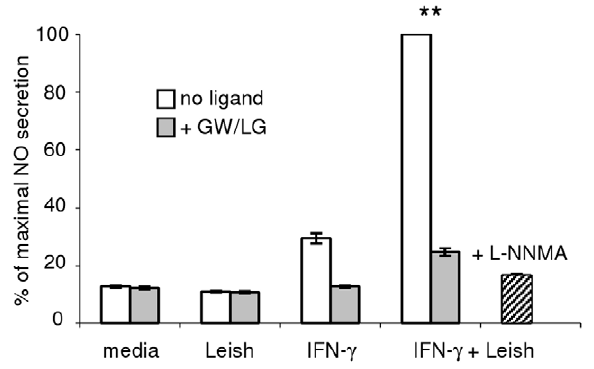
Figure 4. NO production by macrophages stimulated with IFN- c + Leishmania is inhibited by LXR ligands. BMDM were preincubated overnight with LXR (GW = GW3965) and RXR (LG = LG268) ligands, with or without IFN- c , prior to a 1 hour in vitro infection with stationary-phase L. chagasi/infantum . Amount of NO secreted in 24 hours by wild-type BMDM stimulated with IFN- c + Leishmania in the absence of ligand was normalized to 100%. L-NNMA is a NOS inhibitor. Error bars represent standard deviations of triplicate NO measurements. Results are representative of at least 3 independent experiments; ** denotes p ,